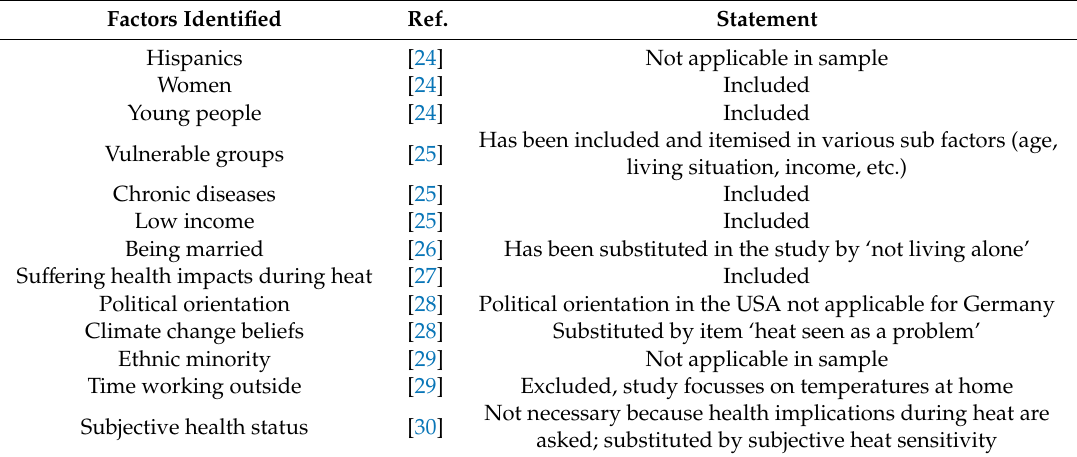
Table 1. Selection of variables to be